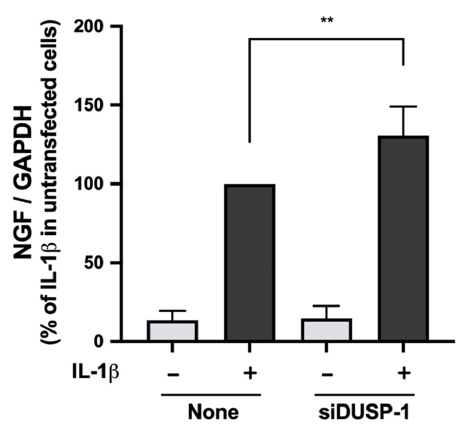
Figure 6. Effects of DUSP-1 knockdown on IL-1 β -induced expression of NGF in human IVD cells. Untransfected and DUSP-1 knockdown human IVD cells were serum starved and stimulated with IL-1 β (10 ng/mL) for 24 h. Expression levels of NGF were quantified by real-time PCR. Results are expressed as the mean ± SD ( n = 4 individuals) after normalization to GAPDH, and are shown as relative values to that of untransfected cells stimulated with IL-1 β . IL-1 β -induced expression of NGF was significantly enhanced in DUSP-1 knockdown cells. ** p < 0.01 vs. untransfected cells stimulated with IL-1 β